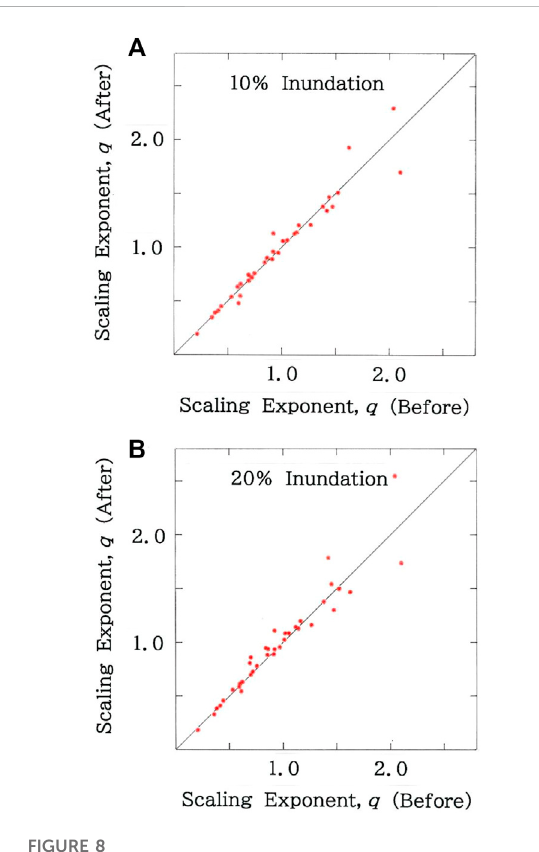
FIGURE 8 Scattergram of scaling exponents after inundation due to the sea level rise versus those before inundation. (A) 10% inundation ( R = 0.9659 with d = 1.073). (B) 20% inundation ( R = 0.9148 with d = 1.405).